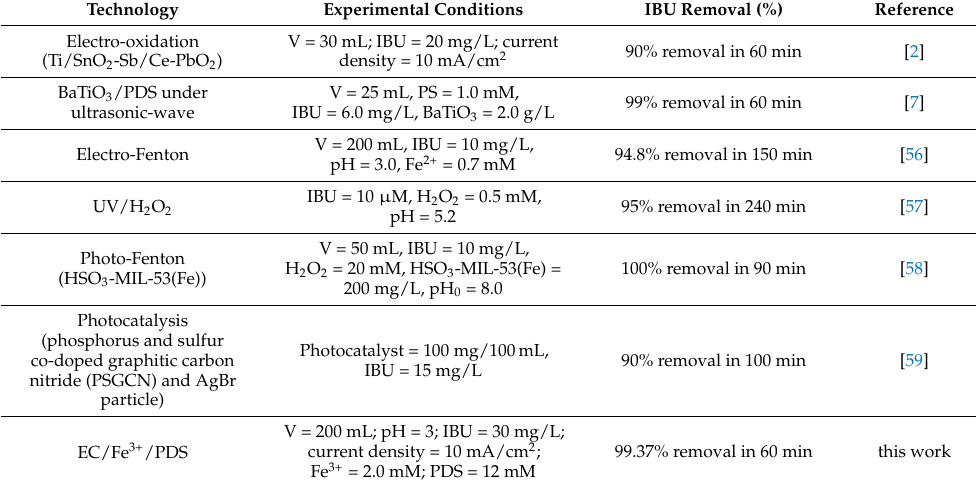
Table 2. Comparison with other technologies for IBU